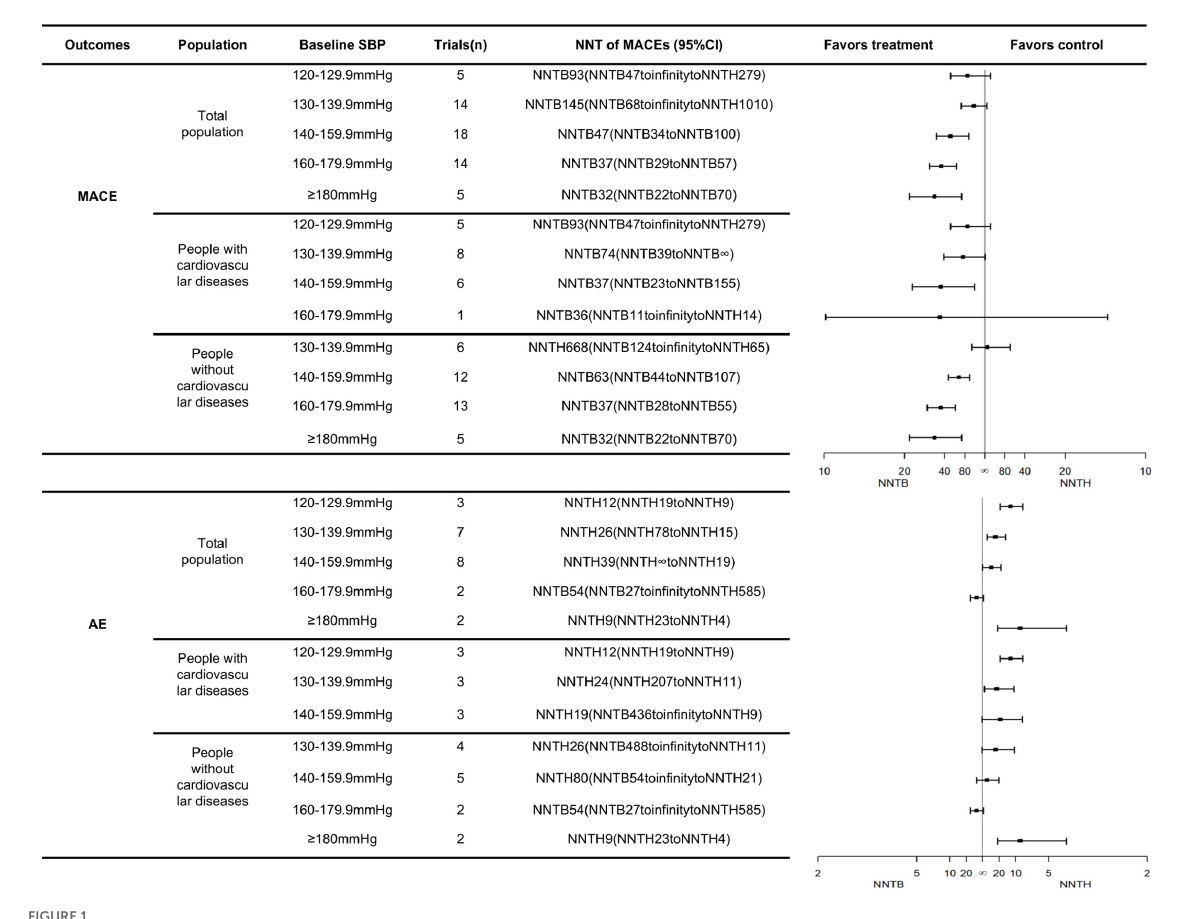
FIGURE1 The NNTs for the primary outcomes across different SBP groups and cardiovascular diseases